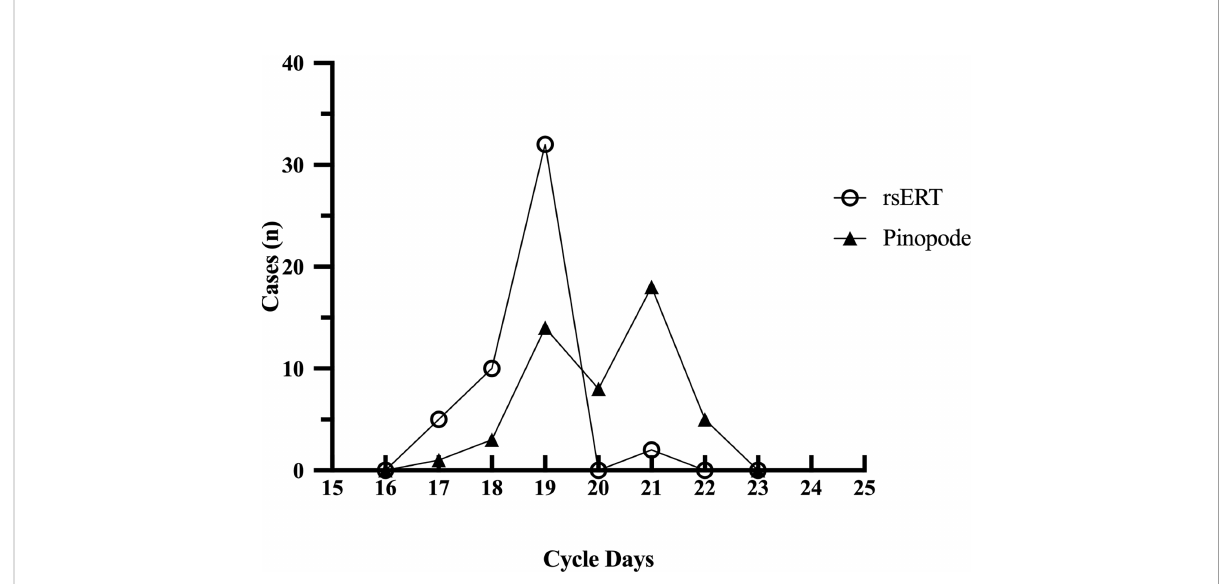
FIGURE 2 Optimal WOIs predicted by rsERT and pinopode of a same RIF group (n=49). The rsERT diagnosed 65.31% of the patients (n=32) with normal WOIs (including 2 patients with prolonged-WOIs), and most of the displacements were advancements (15/49, 30.61%). While according to pinopode, 28.57% (n=14) of the same group were considered with normal-WOIs and 63.27% (n=31) presented delayed pinopode growth